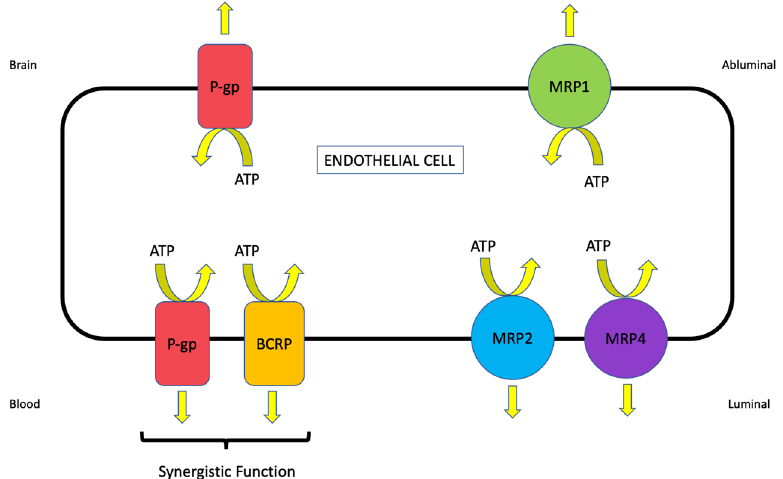
Figure 1. Localization of ABC Transporters in Brain Microvessel Endothelial Cells. Adapted with permission from Nilles et al. ref. [17]. 2022. Copyright 2022 by the authors.